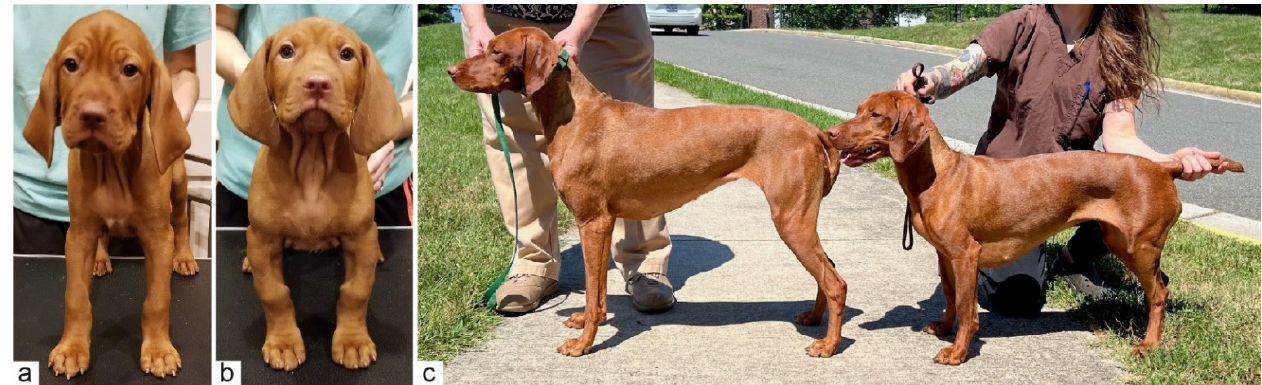
Figure 2. Clinical photos of affected and unaffected Vizslas. ( a ) Unaffected male control puppy at seven weeks of age. ( b ) Affected male littermate (case 1) of the dog shown in ( a ) at the same age. Note the deformity and shortening of both front limbs. ( c ) On the right, a 2-year-old affected female dog (case 6) next to its unaffected 3-year-old half-sister with standard proportions.